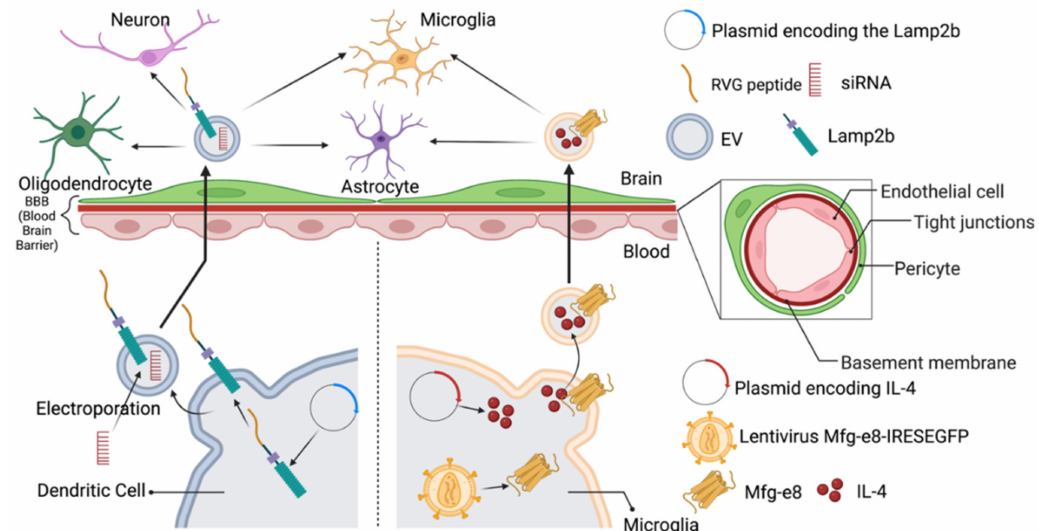
Figure 2. Schematic representation of the engineering of EVs for CNS targeting before isolation. Two studies, as shown in Figure 2, used two different engineering methods before isolation of the EVs from the cell media to deliver therapeutic molecules to the target site in the brain. Dendritic cells were transfected with the targeted gene and fused with RVG peptides to endow the CNS target delivery of EVs, and the therapeutical siRNA was loaded by electroporation before EV isolation. As shown on the right side of the figure, the microglia were infected by a pseudotype virus to overexpress Mfg-e8, and transfected with plasmid coded with IL-4, which has a therapeutical effect on experimental autoimmune encephalomyelitis (EAE) mice. Then, the EVs were produced with a targeting property towards phagocytes in the CNS to treat EAE